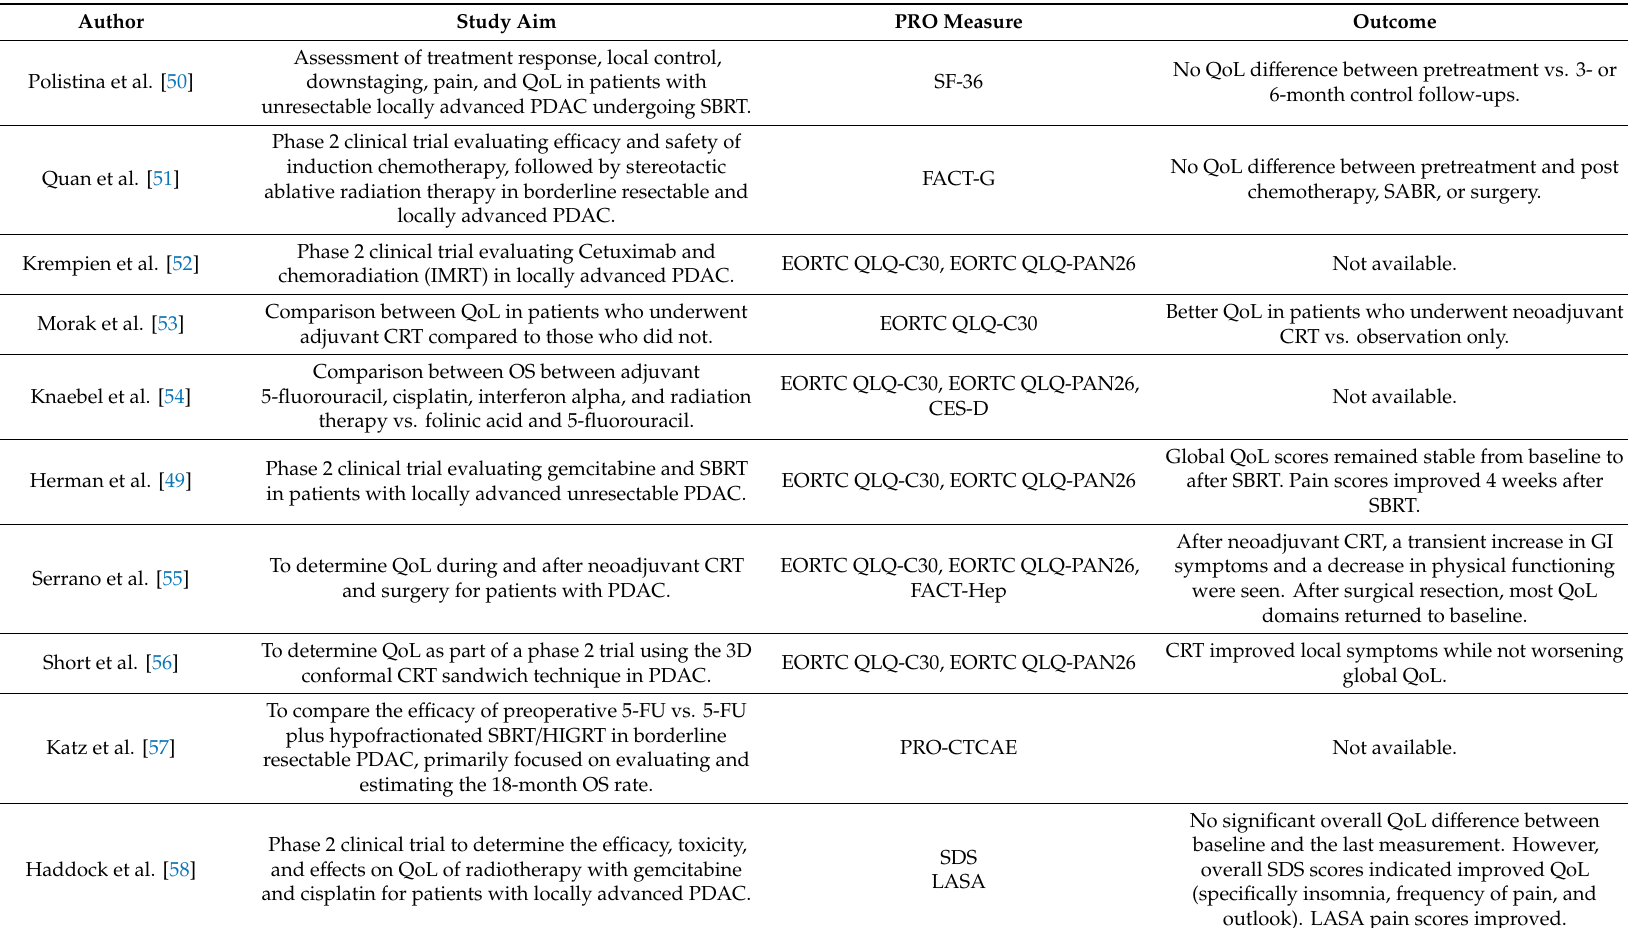
Table 2. PRO in studies of pancreatic cancer involving radiation